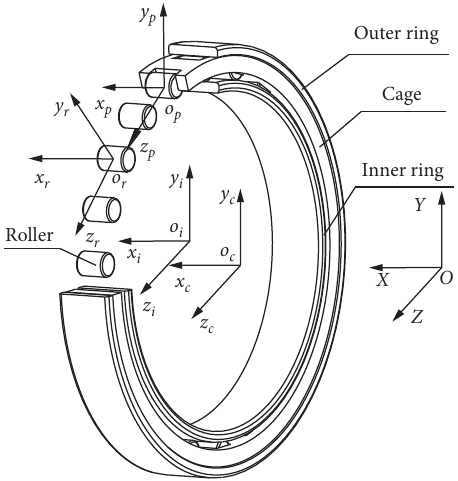
Figure 1: Coordinate systems of